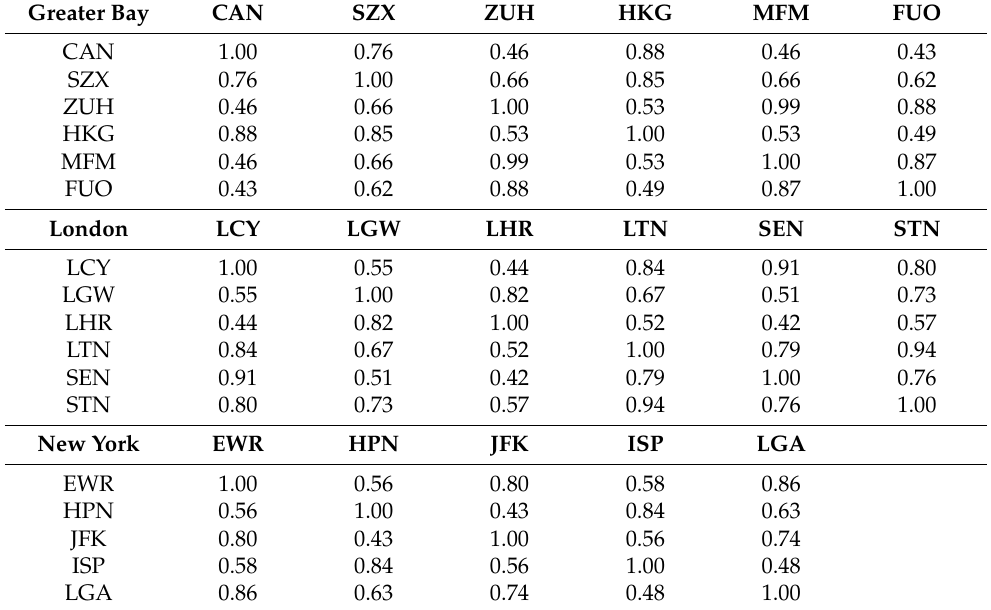
Table A1. Homogenization result of BF.